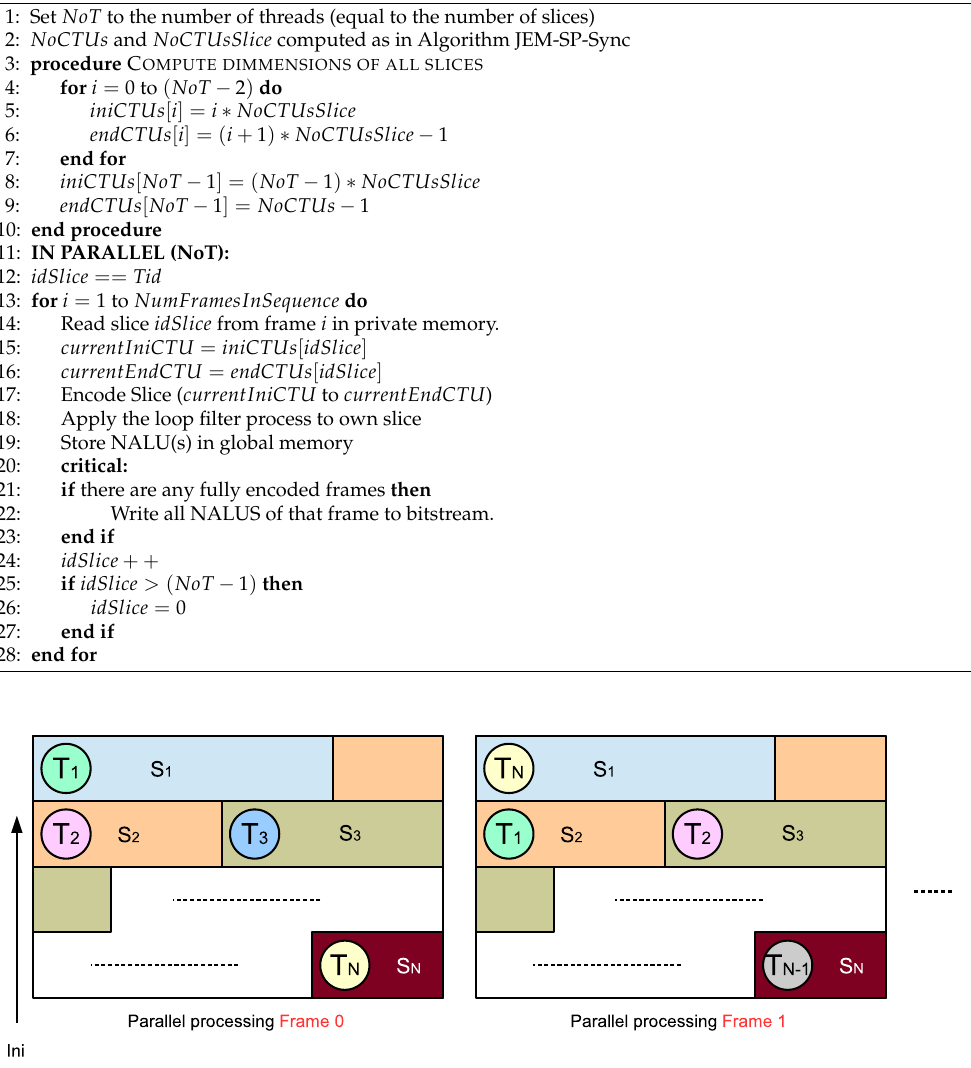
Algorithm 2 JEM-SP-ASync: Slice-based parallel algorithm without synchronization processes.